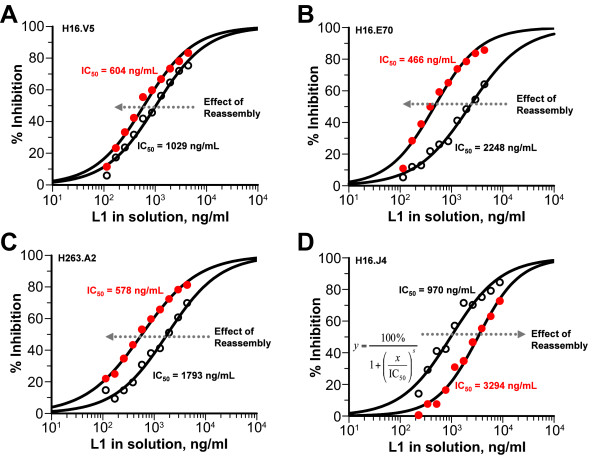
Competitive fluorescence ELISA curves for H16.V5 (A), H16.E70 (B), H263.A2 (C) (conformational epitope and neutralizing) and H16.J4 (D) (linear epitope and weakly neutralizing) on a pair of pre- and post-D/R HPV 16 L1 VLP lots. Fitted curves and the IC50 values were obtained with GraFit (20). Open dots correspond to pre-D/R VLPs; closed dots correspond to post-D/R VLPs. The relative IC50 values (normalized to a reference lot) for multiple full-scale lots are listed in Table 2.